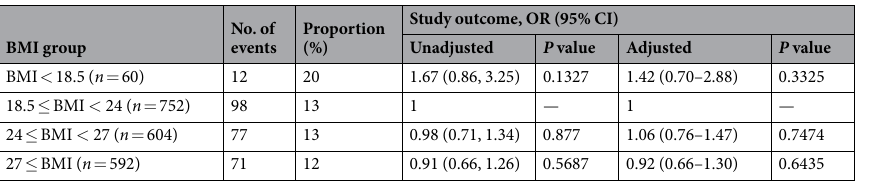
Table 5. Association between BMI and the risk of eGFR progression among patients with CKD stages 1–3a. Models were adjusted for age, sex, DM, CAD, Stroke, cancer, hypertension, Charlson score, TB, COPD, ACEI, ARB, fibrate, smoking, alcohol consumption, betel nut chewing, UPCR and eGFR. OR, odds ratio; CI, confidence interval; BMI, body mass index; DM, diabetes mellitus; CAD, coronary artery disease; CKD; chronic kidney disease; UPCR, urine protein-to-creatinine ratio; eGFR, estimated glomerular filtration rate.